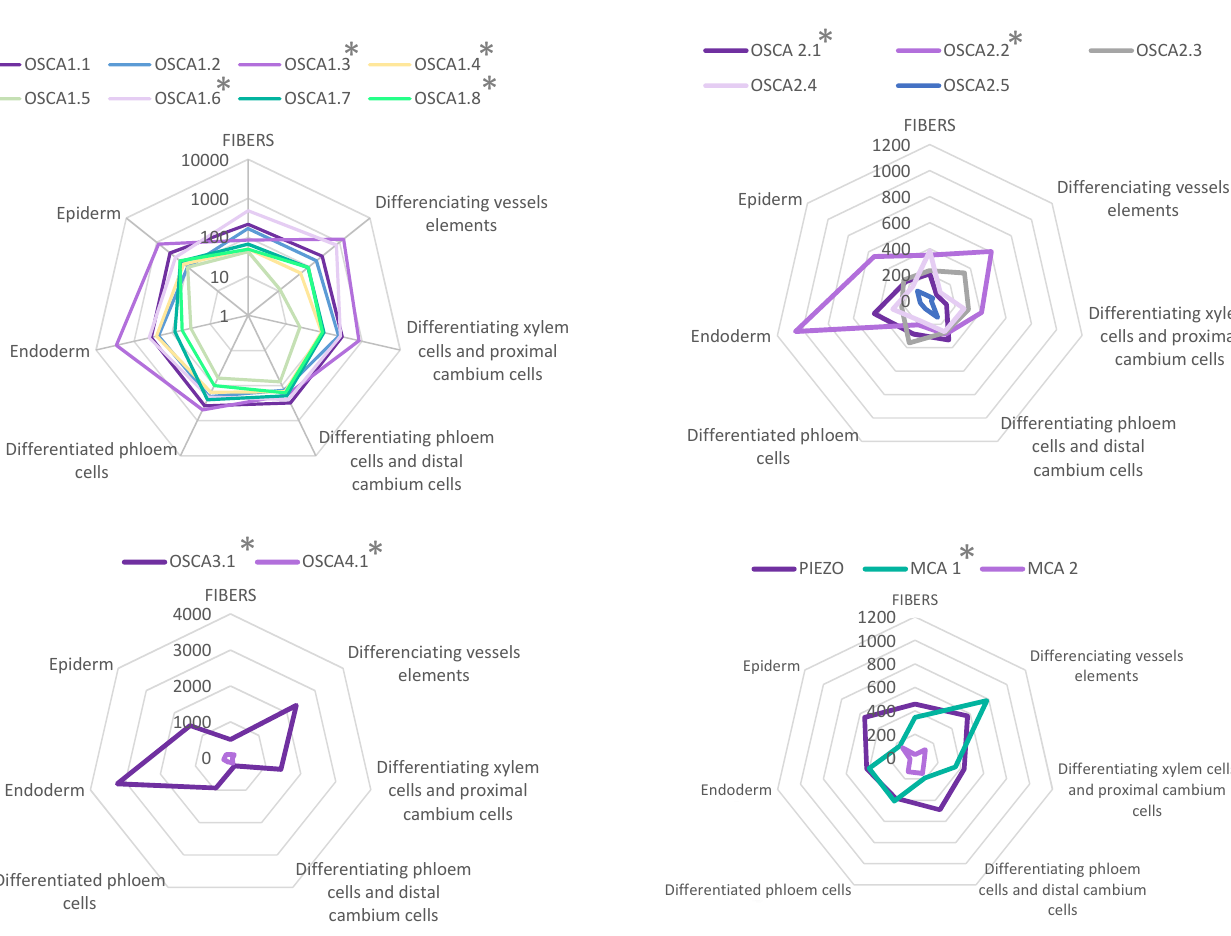
Figure 5. Expression patterns of MCA , Piezo and OSCA genes in different tissues of Arabidopsis mature inflorescence stem. Data were retrieved from the tissue-specific transcriptome study of the mature inflorescence stem of Arabidopsis thaliana [128] realized by analyzing mRNA from specifically labeled- nuclei covering a comprehensive set of distinct tissues (FANS/RNA-seq). Data are available at https://arabidopsis-stem.cos.uni-heidelberg.de (accessed on 20 June 2021). The values of expression levels (0 to 10,000) correspond to the mean of normalized read count values (by DESeq2). n = 3 for each population. * indicates a p -value < 0.01 in a Likelihood Ratio Test (LRT) results (by DESeq2) testing if genes have similar expression among the seven different tissues. See Appendix B.2 for